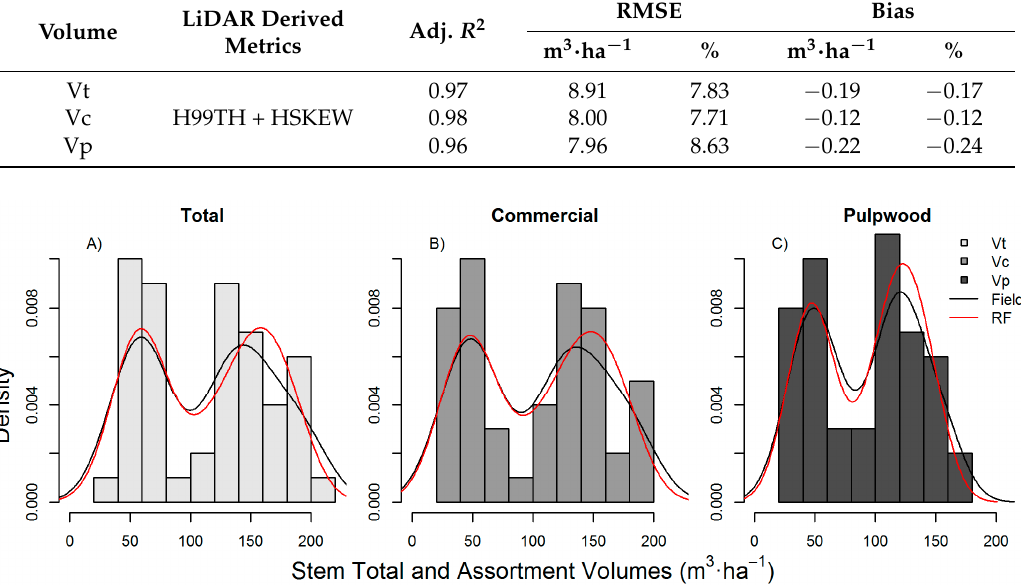
Table 7. Model accuracies of random forest (RF) models per stem volume in terms of Adj. R 2 , Root Mean Square Error (RMSE) and bias calculated by the relationship between predicted and observed stem volumes.